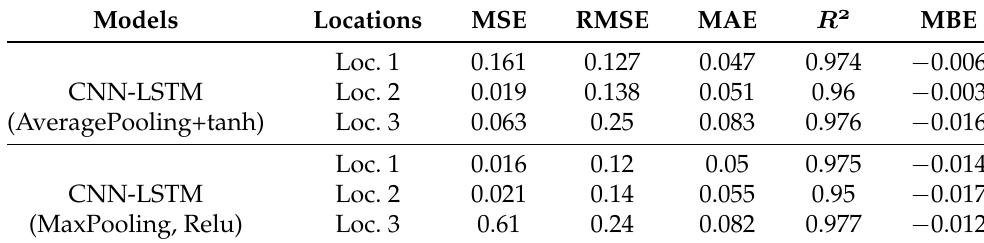
Figure 10. The RMSE and R 2 -score of CNN-BLSTM model during training. The left side shows the R 2 -score and the right side shows the RMSE. Table 8. Performance of the CNN-LSTM model on the test set.